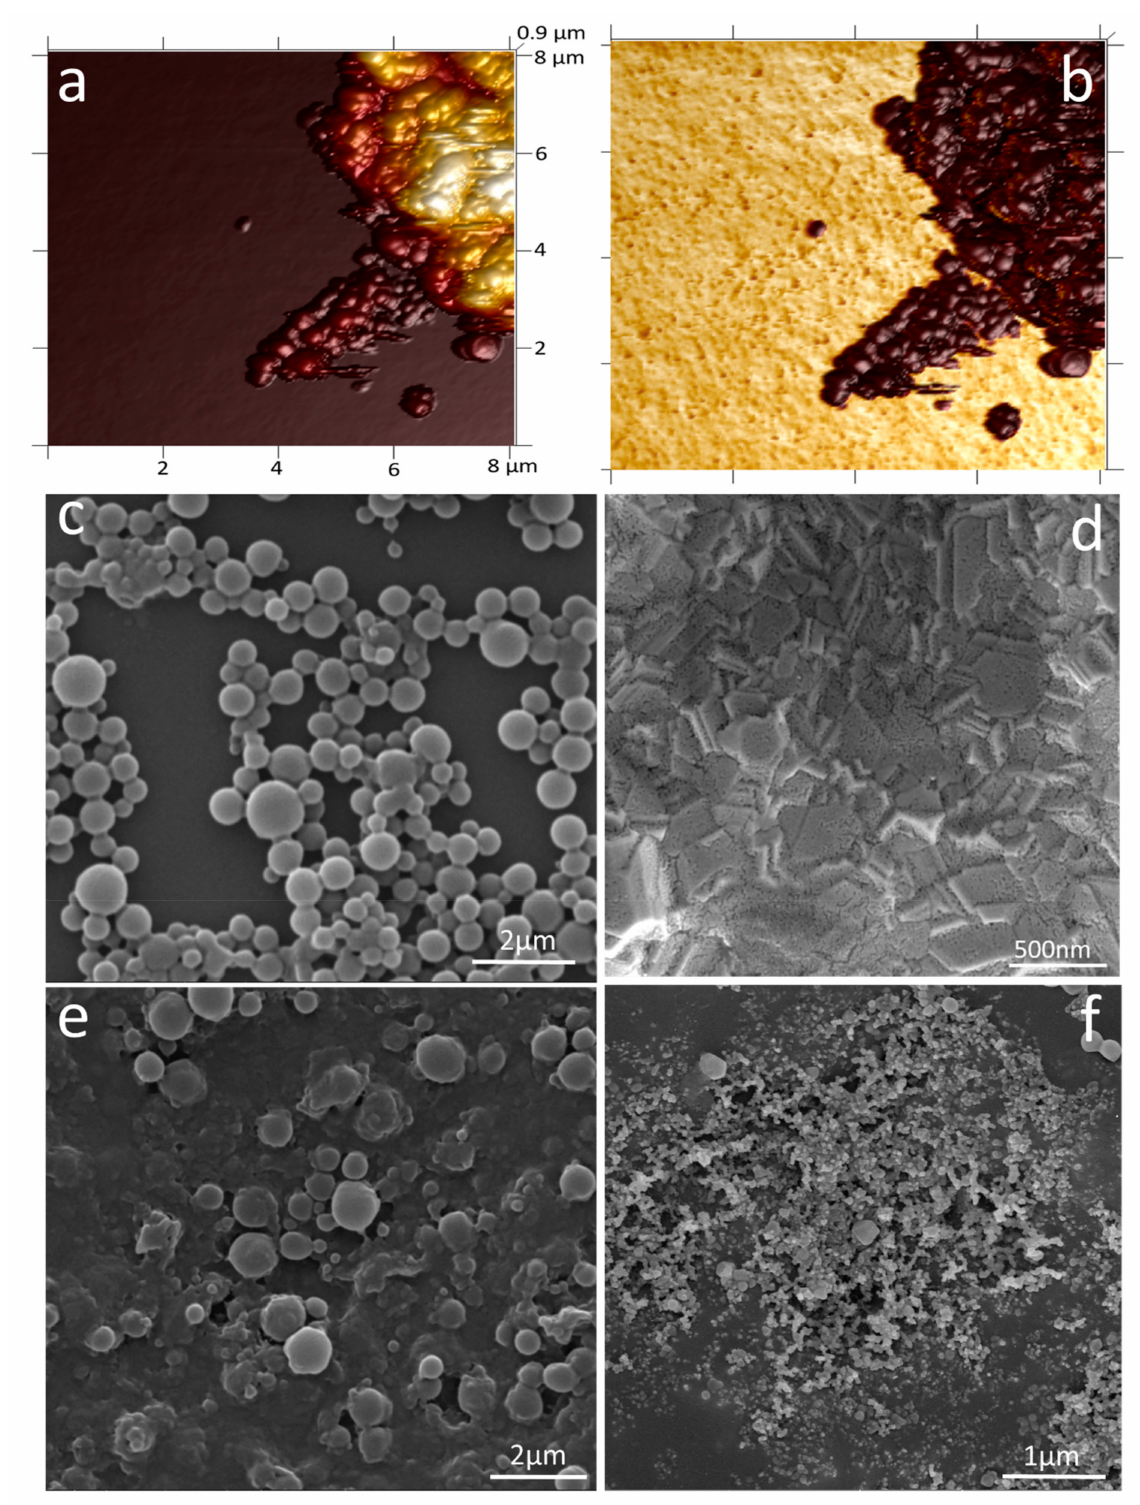
Figure 3. ( a ) AFM of PHB nanobeads on the gold electrode depicting height. ( b ) Adhesion profile of the same region differentiating the gold substrate (yellow) from the PHB beads (brown). SEM images of ( c ) PHB nanobeads, ( d ) bare SPE-Au electrode, ( e ) PHB-modified SPE-Au electrode, and ( f ) PHB-5mC/HRP modified SPE-Au